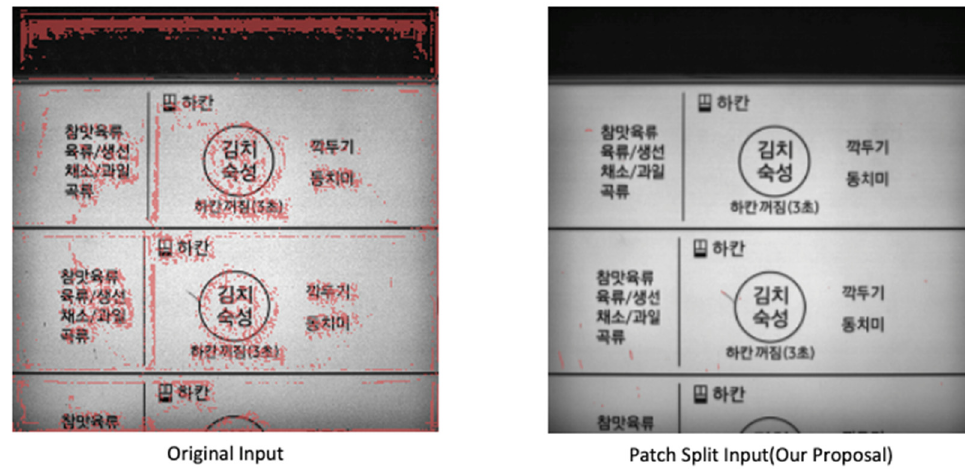
Figure 18. Images detected using original input and patch-split input.